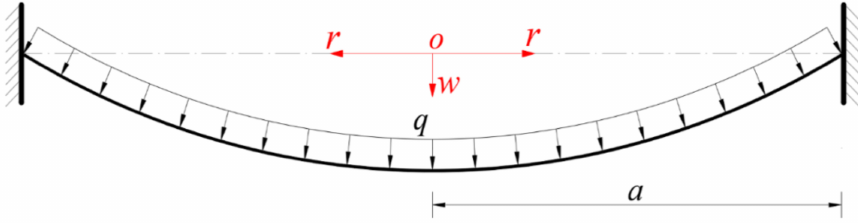
Figure 1. Sketch of the circular membrane under gas pressure q .